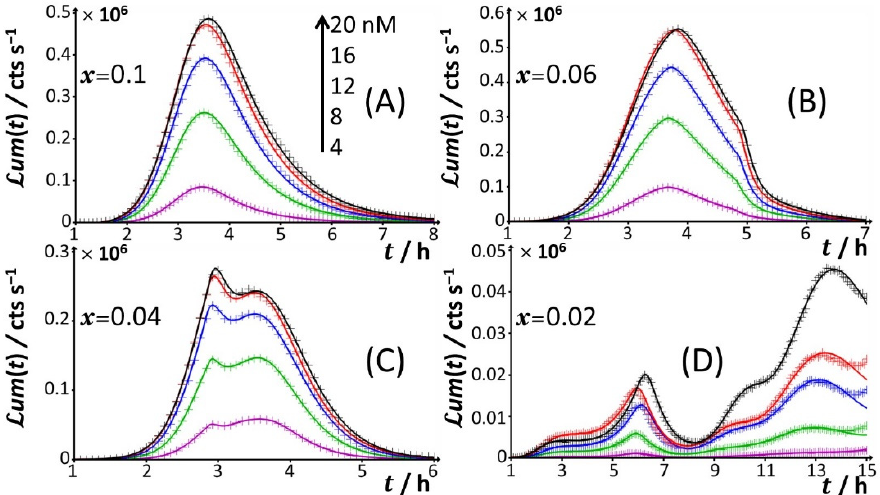
Figure 4. Time-dependence of bioluminescence ( L um ( t )) measured for the Cd-responsive E. coli biosensor as a function of total Cd concentration in the range of 0–20 nM (indicated) in nGGM media supplemented with 0.1% tryptone and different concentrations of glucose and xylose (subsumed in the variable x ). Data are given for selected values of x , and they refer to the only peak P1 identified in Figures 1 and 2. The scale in Cd concentration and associated color nomenclature specified in ( A ) apply to panels ( B – D ). (+) symbols: experimental data. Lines: reconstruction on the basis of the theory outlined in Section 3. Signals were corrected by point-by-point subtraction of the corresponding cell response measured in 0 nM Cd concentration. See text for details.